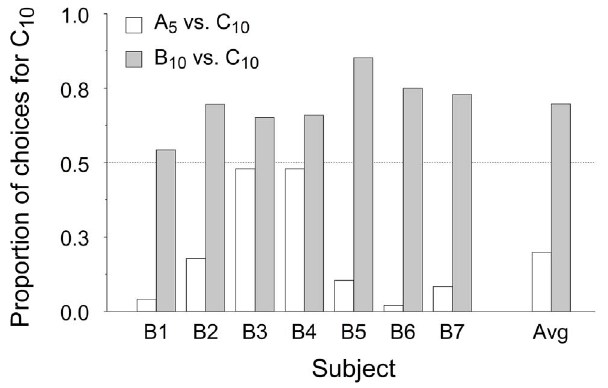
Figure 2. Proportion of choices for option C 10 in both preference tests. White and grey bars show preference for C 10 in the A 5 vs. C 10 and B 10 vs. C 10 tests, respectively. The rightmost columns show average data. The horizontal dashed line indicates chance level.